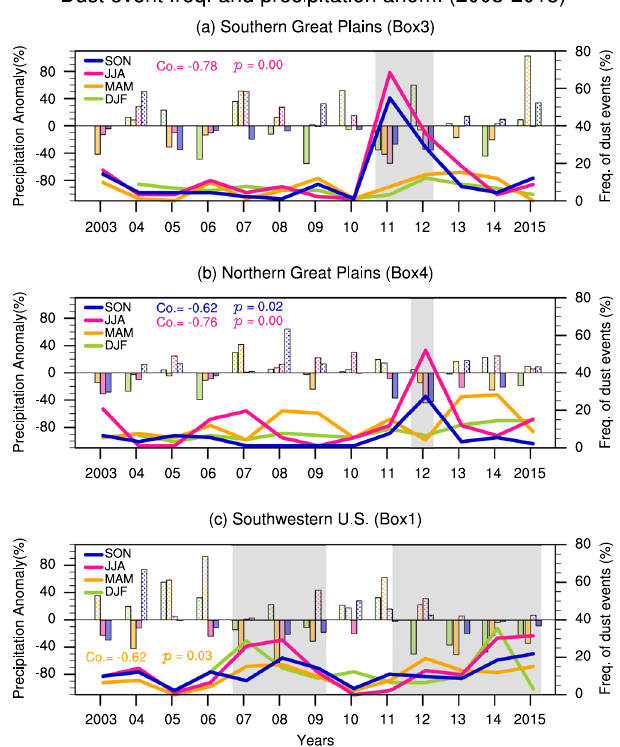
Figure 2. Dust event frequency and precipitation anomaly. Time series of the dust event frequency (%; lines) and precipitation anomaly (in percentage with reference to the 2003–2015 climatology; bars) in the southern Great Plains (SGP; Box 3 in Fig. 1), northern Great Plains (NGP; Box 4), and the southwestern U.S. (Box 1) for each season (light green for winter, orange for spring, magenta for summer, and navy blue for fall). Recent drought years are shaded in grey. Correlation coefficients between the precipitation and dust event frequency above the 95% confidence level (t-test) are listed (color denoting seasons).